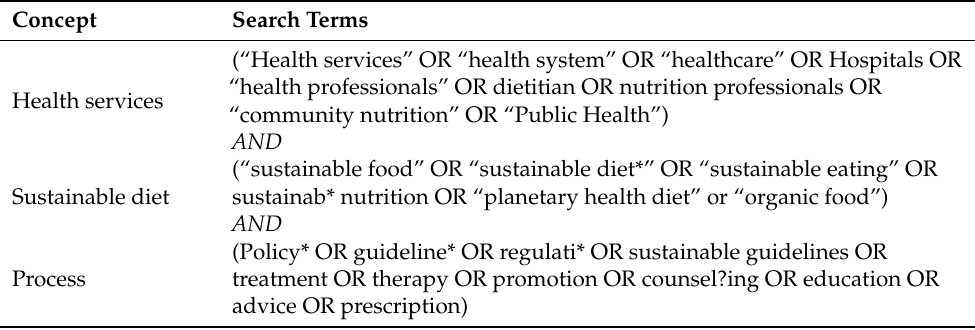
Table 1. Search terms used for each of the concepts.